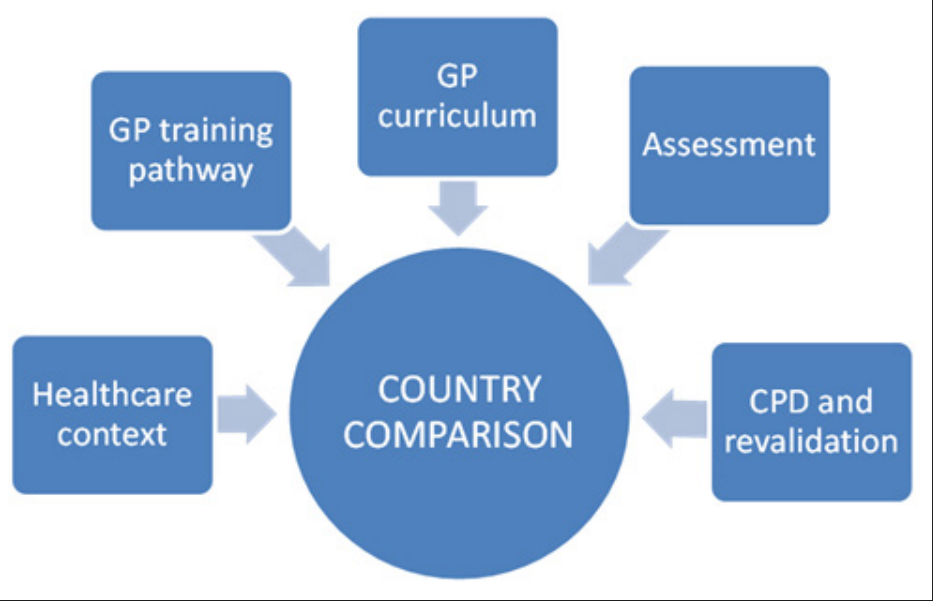
Figure 3 Overview of the key domains covered within the mapping